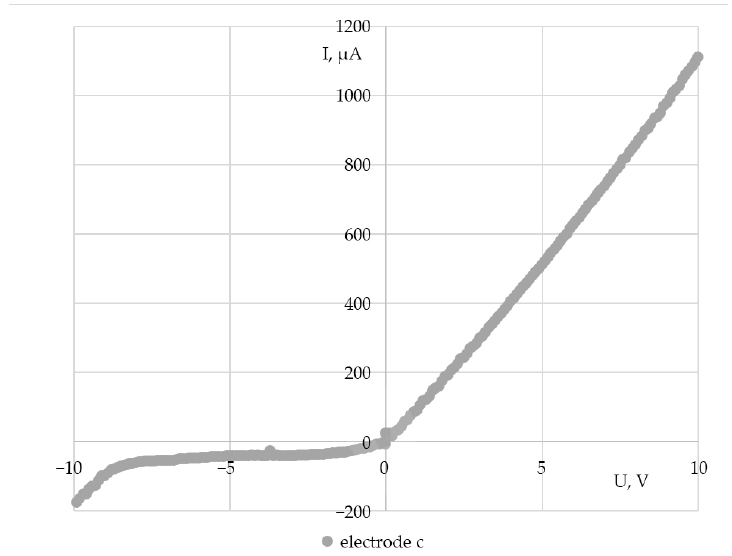
Figure 9. The current–voltage characteristics of the sample taken with electrode (c).